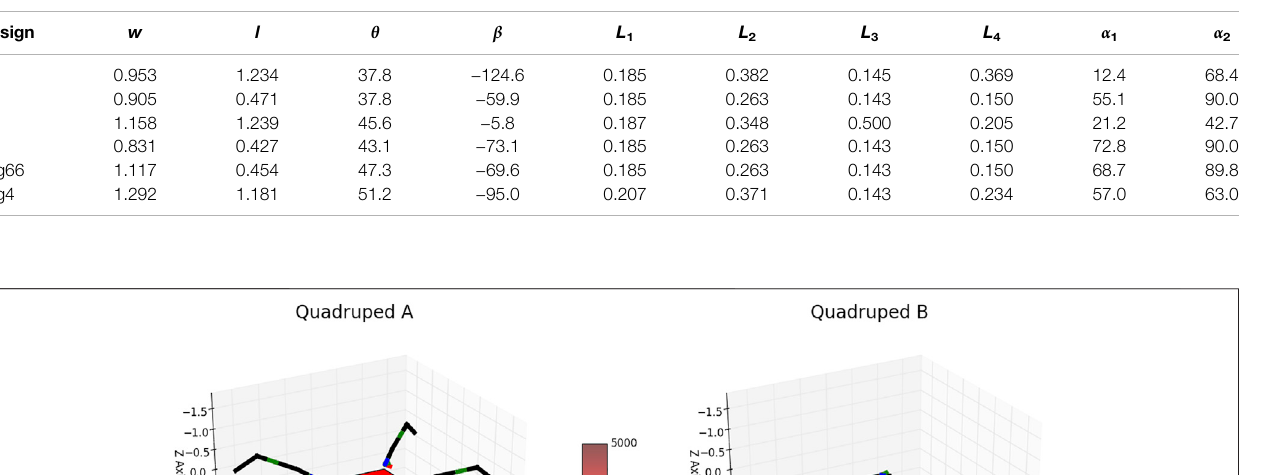
Frontiers in Robotics and AI |